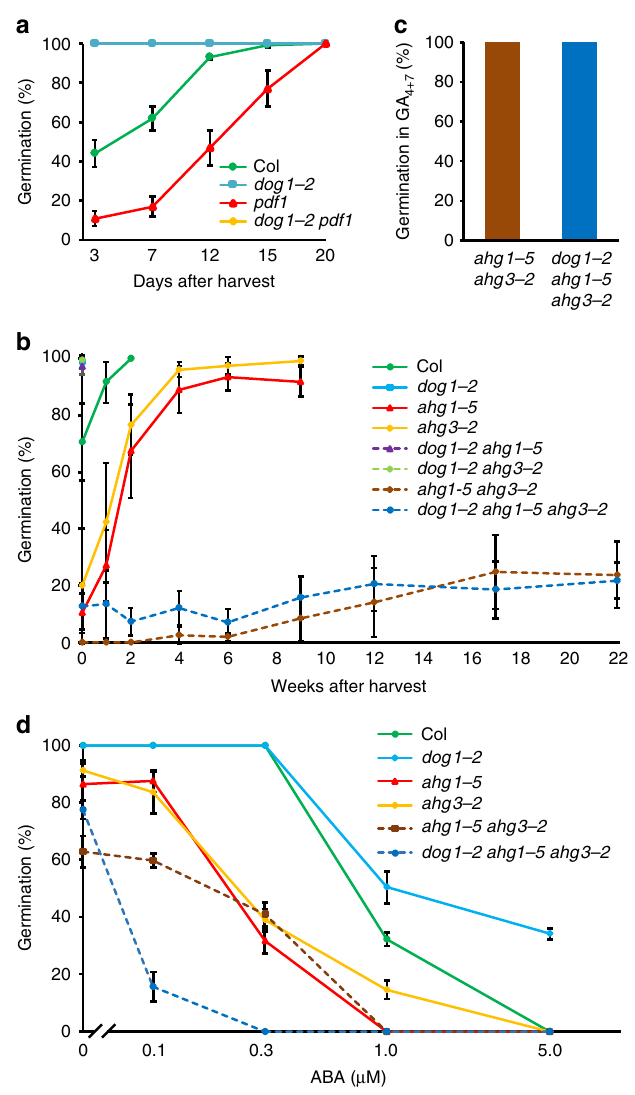
Fig. 4 Genetic relations between mutants in DOG1 and its interacting phosphatases. a Germination after different periods of dry storage of the single mutants dog1-2 and pdf1 , the double-mutant dog1-2 pdf1 , and their wild-type background Col. The dog1-2 mutant is epistatic to pdf1 (note that the dog1-2 pdf1 line is behind the dog1-2 single mutant line). b Germination after different periods of dry storage of the single mutants dog1-2 , ahg1-5 , ahg3-2 , the double mutants dog1-2 ahg1-5 , dog1-2 ahg3-2 , ahg1-5 ahg3-2 , the triple mutant dog1-2 ahg1-5 ahg3-2 , and their wild-type background Col. The ahg1 and ahg3 mutants have redundant roles in dormancy and are epistatic to dog1 . The dog1-1 mutant and the double mutants dog1-2 ahg1-5 and dog1-2 ahg3-2 are completely non-dormant, their symbols are overlapping in the top left corner of the graph (100% germination, 0 weeks after harvest). c Germination in 100 µ M GA 4+7 of seeds from the ahg1-5 ahg3-2 double mutant and the dog1-2 ahg1-5 ahg3-2 triple mutant that were stored for 18 weeks. d Dose – response effect of ABA on germination behaviour of the same genotypes as in b . Seeds were after-ripened for 1 year and strati fi ed for 3 days to enhance their germination potential. Shown are averages ± s.d. of 6 – 12 a , b , c or three d independent batches of seeds for each